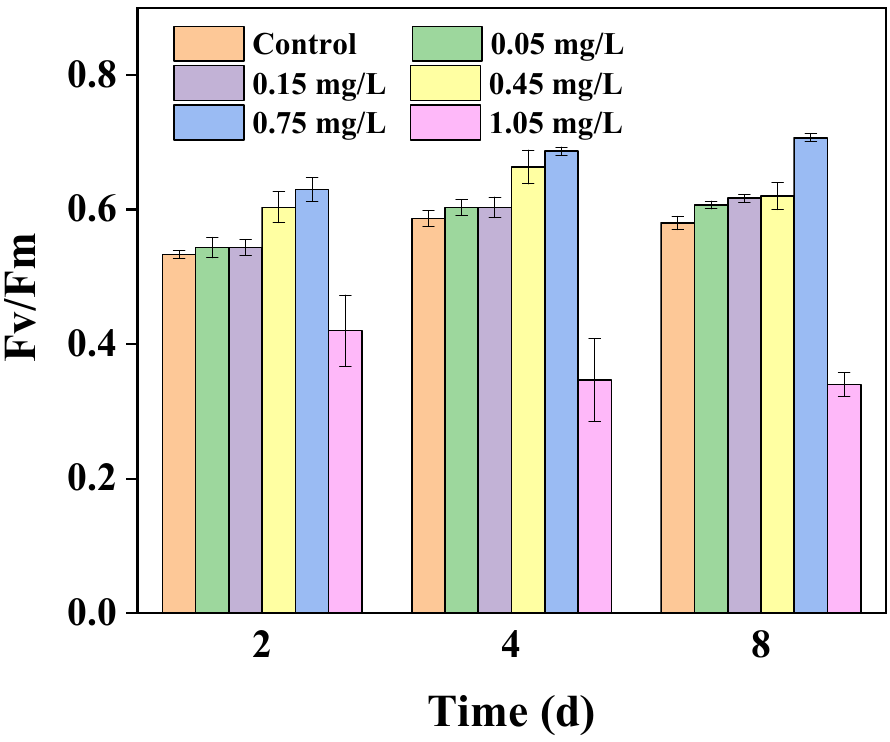
Figure 3. Effects of triclosan on the Fv/Fm value of Chlorella vulgaris . ϕ PSII reflects the actual photochemical efficiency of the PSII reaction center. Figure 4a shows the results of triclosan toxicity experiments with increasing triclosan exposure concentrations. It was found that ϕ PSII values increased by 8.11%, 5.41%, 24.32% and 43.24%, as measured on the 8th day, in samples exposed to 0.05, 0.15, 0.45 and 0.75 mg/L of triclosan, respectively, as compared with the control groups. However, ϕ PSII values decreased by 78% in 1.05 mg/L triclosan treatment, and the effects of triclosan on ETR max were similar to its effects on ϕ PSII (Figure 4b). A low concentration of triclosan was able to increase the value of ETR max ( p < 0.01), whereas the value of ETR max decreased greatly when the concentration was increased to 1.05 mg/L. Statistical analysis results indicate that the inhibitory effects of triclosan on the ϕ PSII ( p < 0.01) and ETR max ( p < 0.01) of Chlorella vulgaris may be highly strengthen in 1.05 mg/L treatments, compared with the control groups during the first 2 days of exposure. Moreover, with the extension of the exposure time, 1.05 mg/L triclosan treatments exhibited negligible ( p > 0.05) changes. This may suggest that high-concentration triclosan inhibited the photosynthetic rates of Chlorella vulgaris mainly through the electron transfer chain.